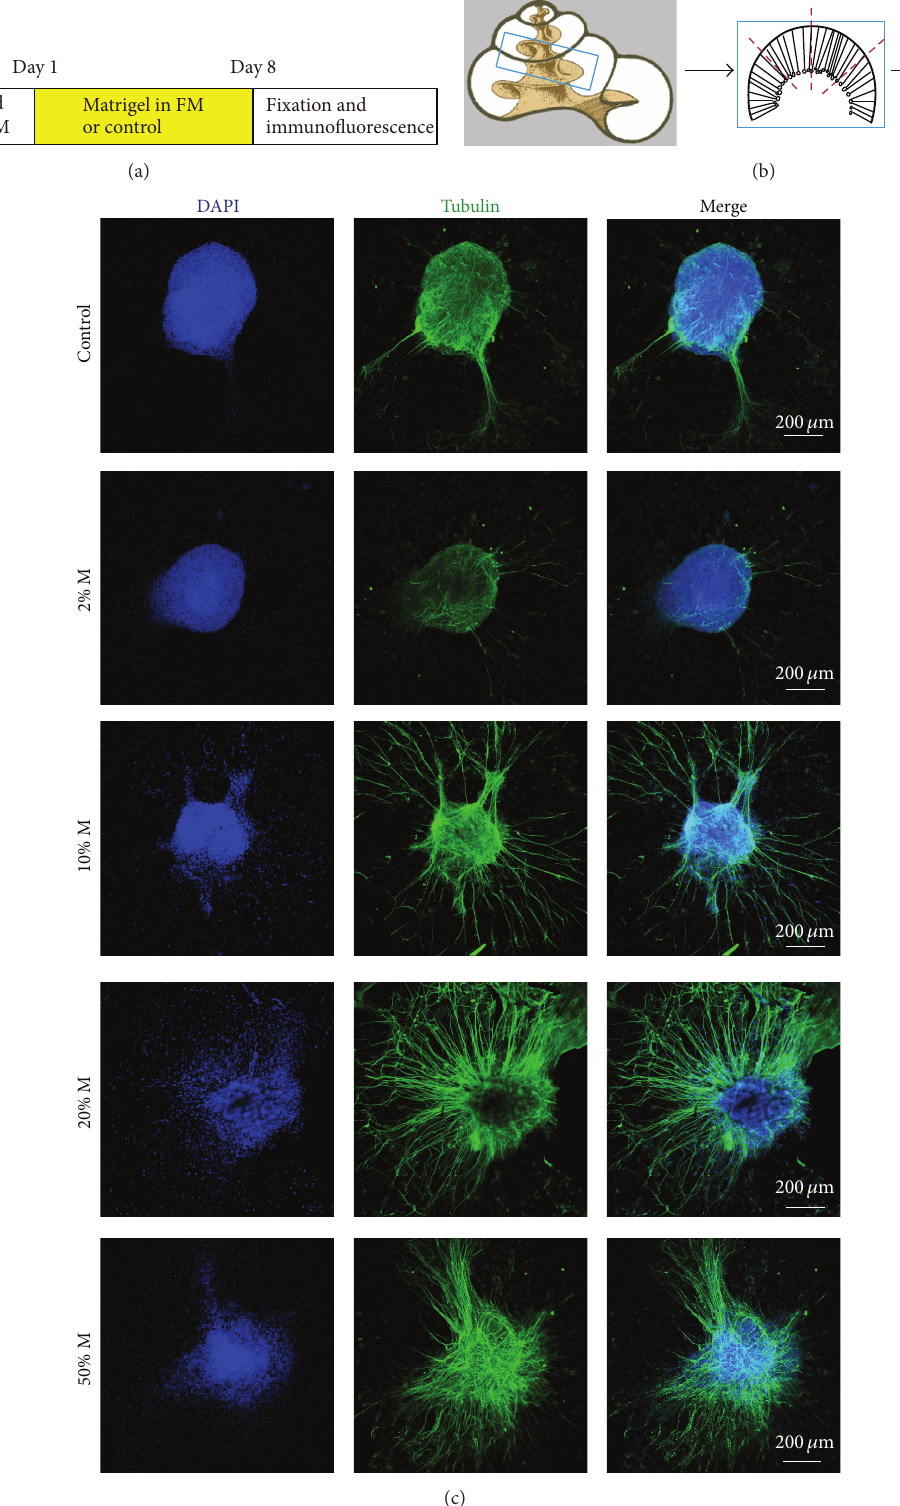
Figure 1: Immunofluorescence imaging of SGN explants cultured with different concentrations of matrigel. (a) The diagram of the assay. (b) The schematic of dissection and culture of SGN explants from neonatal mice cochleae. The middle turn of P3 cochlea was dissected out, the stria vacularis, the organ of Corti, and modiolus were discarded, and remnant SGN bulk was cut into four equal pieces, attached to coverslips,andcultured.(c)RepresentativeSGNexplantsstainedwithDAPI(blue)andanti- 𝛽 -tubulin(green)antibodyforeachexperimental